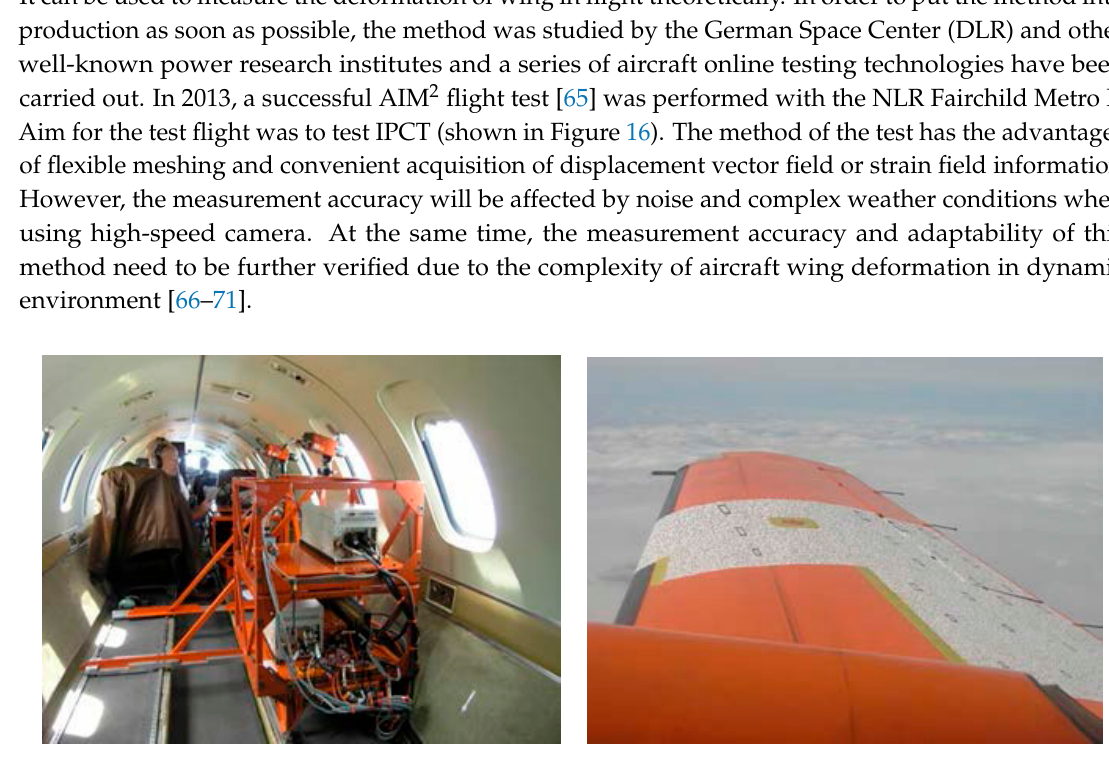
Table 2. Analysis of the characteristics of three measuring methods.